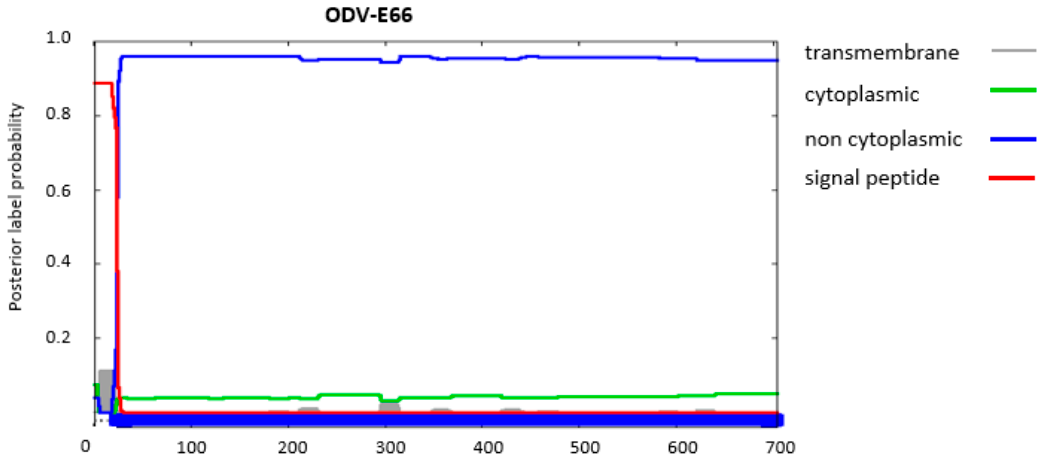
Figure 8. Prediction the presence of a transmembrane domain and signal peptides in ODV-E66 and orientation of this protein in an infected host-cell with the Phobius algorithm [17]. On the y -axis: the probability for the presence of transmembrane domains (grey), cytoplasmic (green) or non-cytoplasmic ( blue ) orientation of the sequence and a signal peptide (red). The final result of the prediction is summarized by the bar at the bottom with the indicated colours. The x -axis shows the number of the amino acids of that specific sequence.